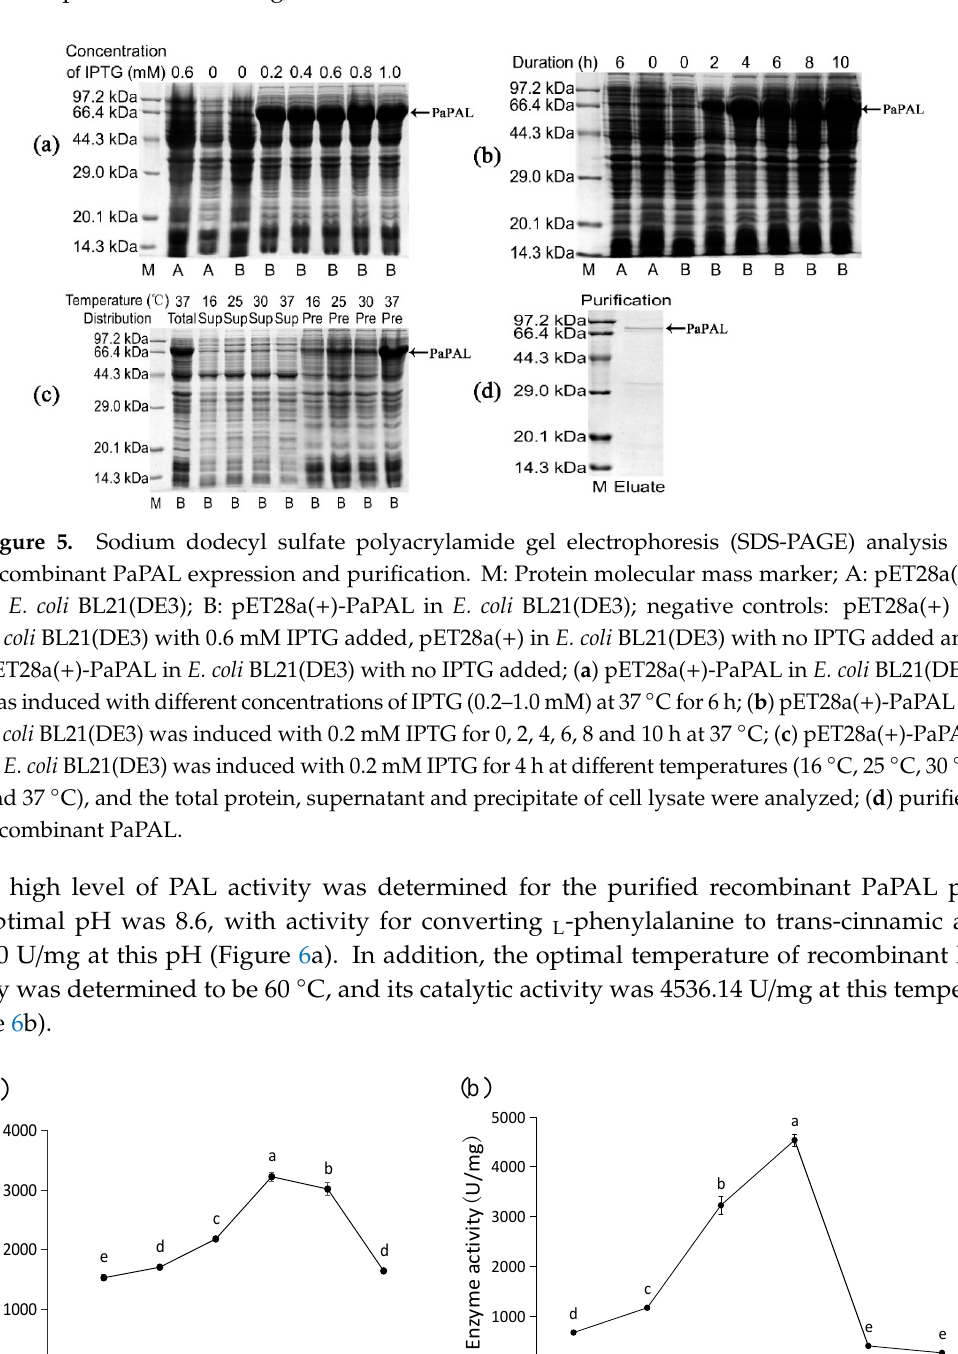
Figure 6. Functional characterization of recombinant PaPAL. ( a ) Optimal pH analysis of recombinant PaPAL; ( b ) optimal temperature analysis of recombinant PaPAL. The data represent the mean values of three replicates ± standard errors (SEs). The different letters (a, b, c, d and e) on the SE line represent statistically significant differences at p ≤ 0.05 (Duncan´s multiple range test).